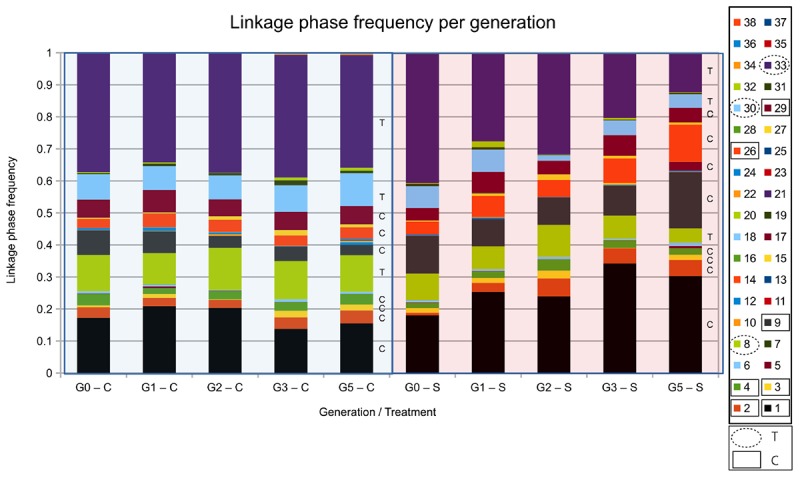
Linkage phase disequilibria during the selection process. Frequency of the haplotypes calculated in PHASE for each generation of selection. The first letter in the x-axis label indicates generation of selection (G0, G1,…, G5) and the last letter indicates treatment [Control (C) or Selection (S)]. Linkage phase disequilibrium was calculated for the six SNPs that were located in the highly supported region of selection as indicated by Jalvingh et al. (2014). Allelic composition and change in frequency of the eight haplotyptes that showed a frequency change larger than 0.01 are shown in Table 4. Many of the haplotypes were rare (<1%); for haplotypes that were more common (>2% in the fifth generation), we indicate whether it carried the C- or the T-allele for the gene mbl.